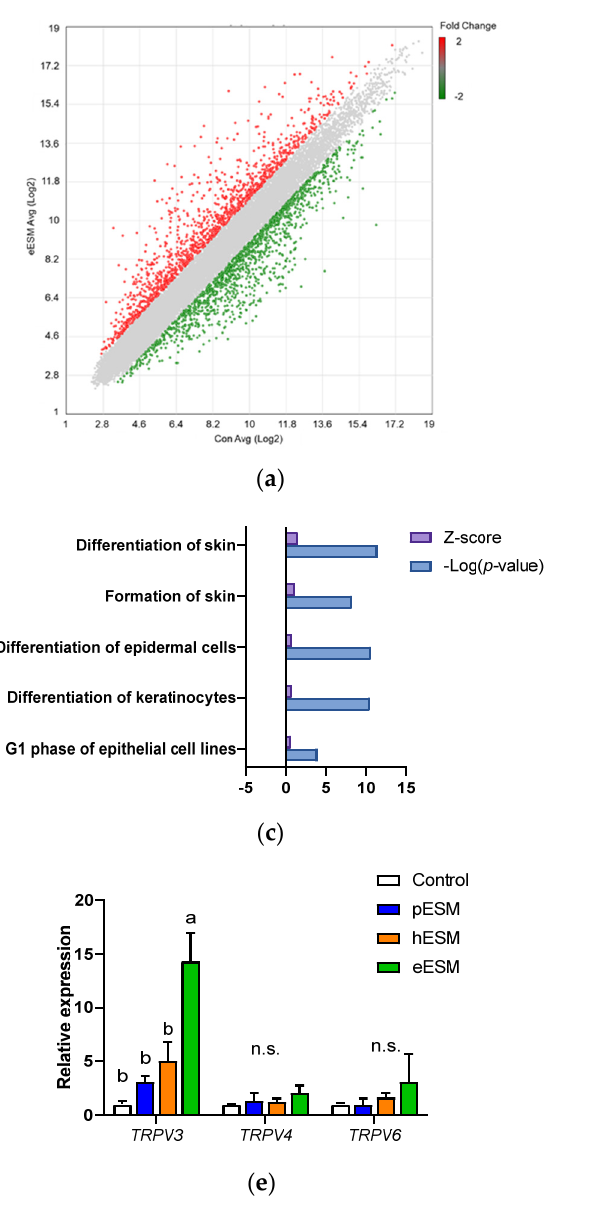
Figure 2. DNA microarray analysis of eESM ­ treated NHEK ­ Neo cells. ( a ) Scatter plot of microarray data. Each dot represents the fold changes in gene expression. The values on the X and Y axes are the signal values (Log2 scaled) of the control and eESM groups, respectively; ( b , c ) Canonical analysis ( b ) and disease and function analyses ( c ) using IPA software. In both analyses, the cut-off condition was |Activation Z-score| > 1, and data was sorted by − Log ( p -value); ( d – f ) results of real-time RT-PCR on keratinocyte differentiation markers ( d ), genes related to keratinocyte differentiation and calcium signal ( e ) and calcium channel ( f ). Data are means ± SD ( n = 3) and expressed as fold change values compared with the control group. ND means the expression of the genes was not detectable in our method. The different lowercase alphabets indicate significant differences between the tested-group ( p < 0.05).; n.s.: not significant. Table 2. List of major genes related to “Formation of skin”.